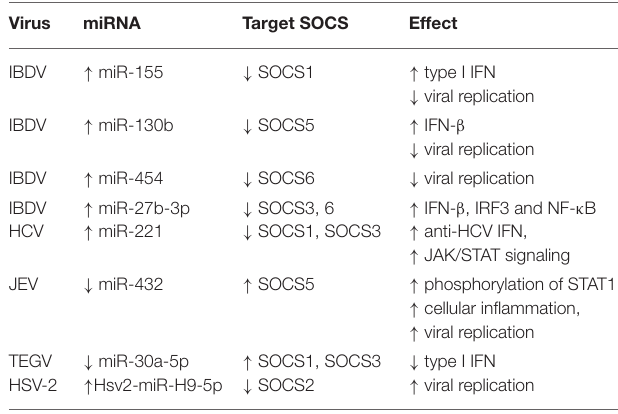
TABLE 2 | MicroRNAs regulate innate immunity through SOCS